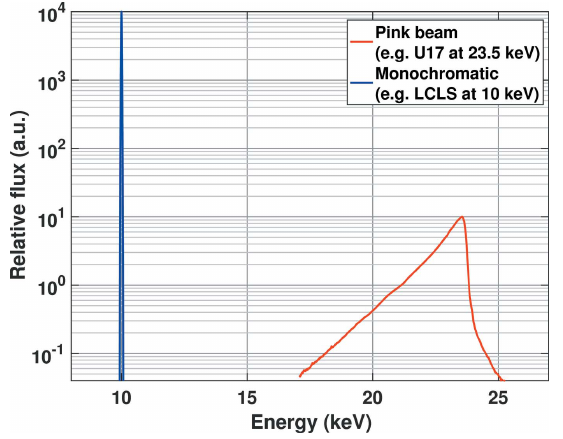
Figure 1 Plot of representative (not measured) X-ray photon energy versus flux at the Linac Coherent Light Source (blue) and U17 flux measured at the Dynamic Compression Sector